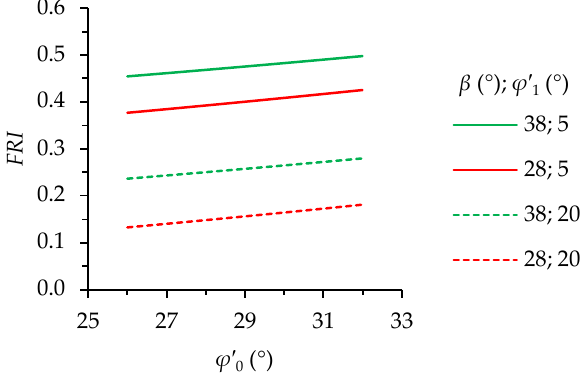
Figure 6. FRI as a function of φ ′ 0 for slope angles β and φ ′ 1 , taking c ′ 1 / c ′ 0 = 0.4.